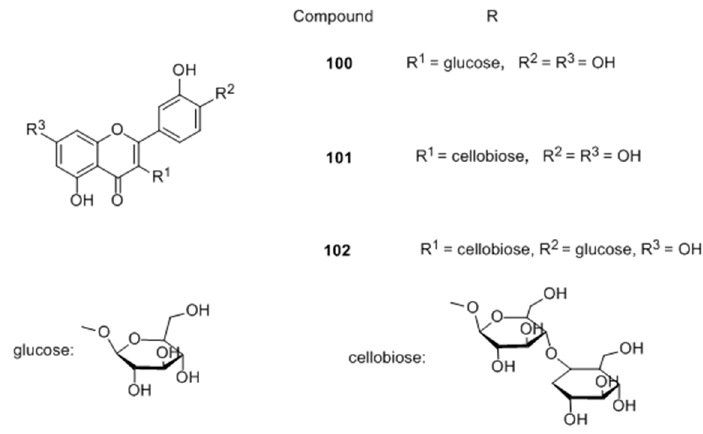
Figure 13. Structures of the synthesized quercetin glycosides.